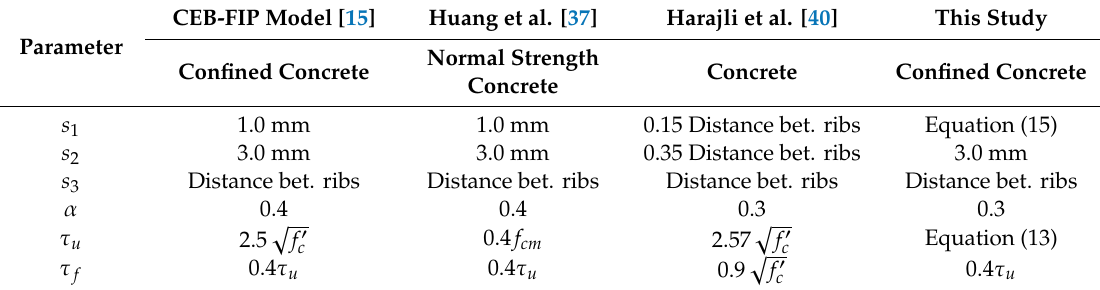
Figure 16. Analytical bond stress–slip relationship (CEB-FIP Model Code 2010). Table 8. Parameter values of the prediction model for the bond stress–slip